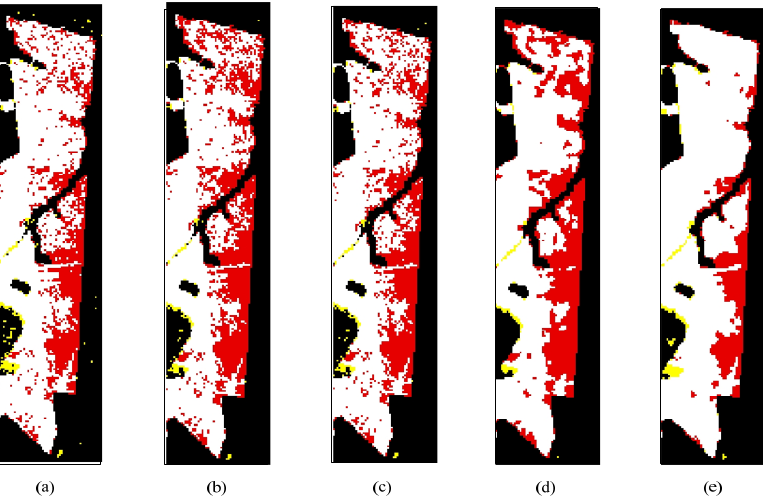
Figure 13. Close-up shot of Mexico data ( a ) FCM; ( b ) FLICM; ( c ) RFLICM; ( d ) sRSFCM; and ( e ) RSFCM.